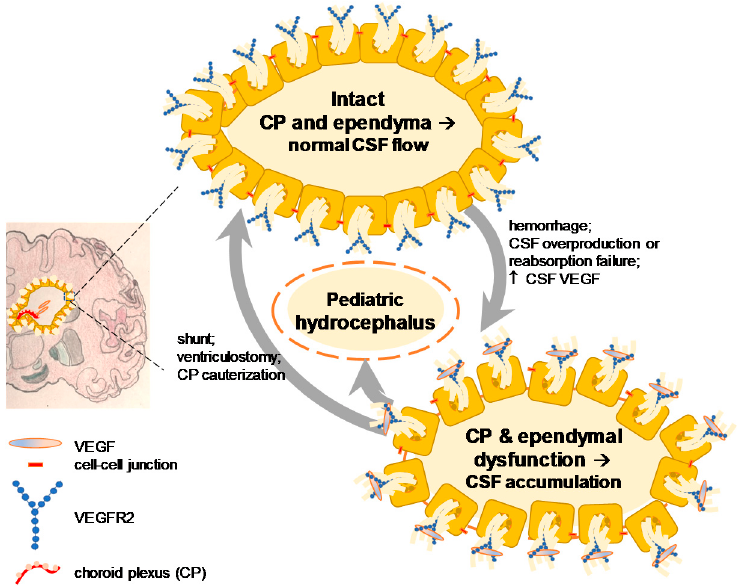
Figure 2. Role of VEGF signaling in post-hemorrhagic hydrocephalus from young individuals: pediatric patients with hydrocephalus have shown an elevated CSF VEGF up to 1 ng/mL [43] and that the infusion of the same dose VEGF into young adult rats results in experimental hydrocephalus. VEGF is considered pathologically causative and anti-VEGF therapy has been proposed [16]. CP, choroid plexus; CSF, cerebrospinal fluid.